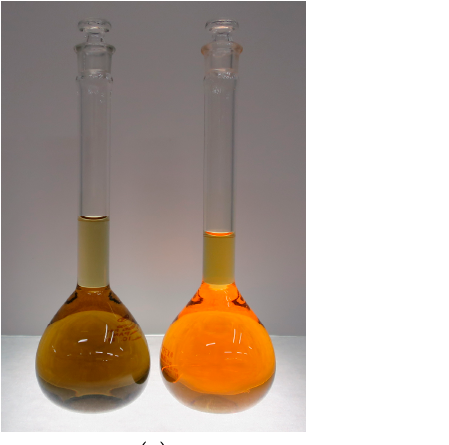
( b ) UV-visible optical absorption spectra of C23M77NS and M100NS. The concentration of the